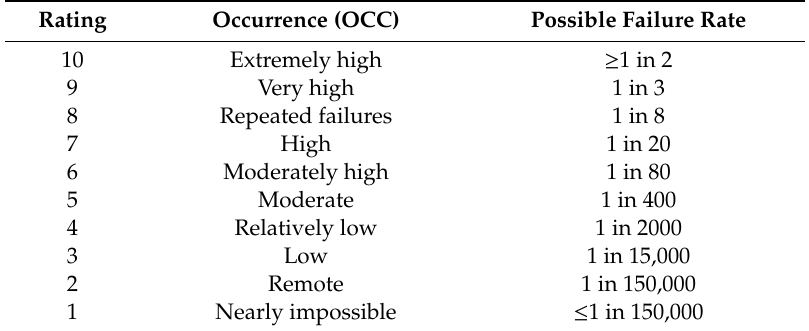
Table 1. Traditional ratings for failure mode’s occurrence (OCC) [17].